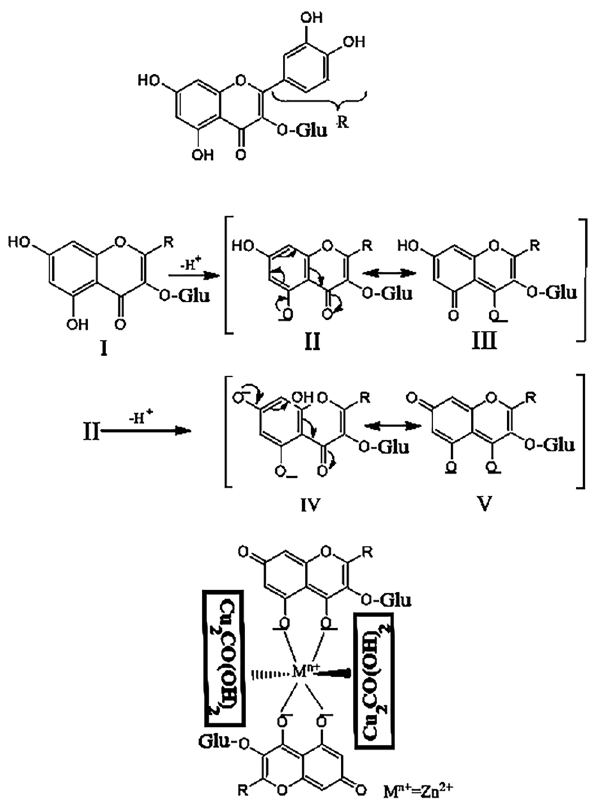
Figure 5. A proposed schematic mechanism of ZnO/Mlt-NC biofabrication based on isorhamnetin-3-O- glucoside in the plant extract.